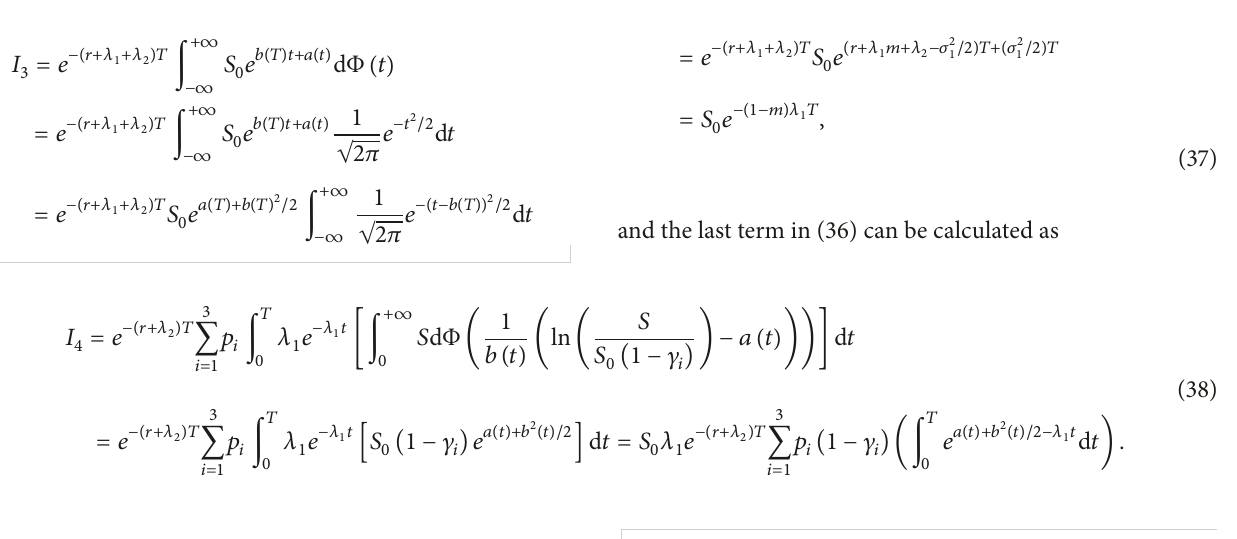
= 0.2, 𝜎 = 0.4 , and 𝐾 = 100 1 2